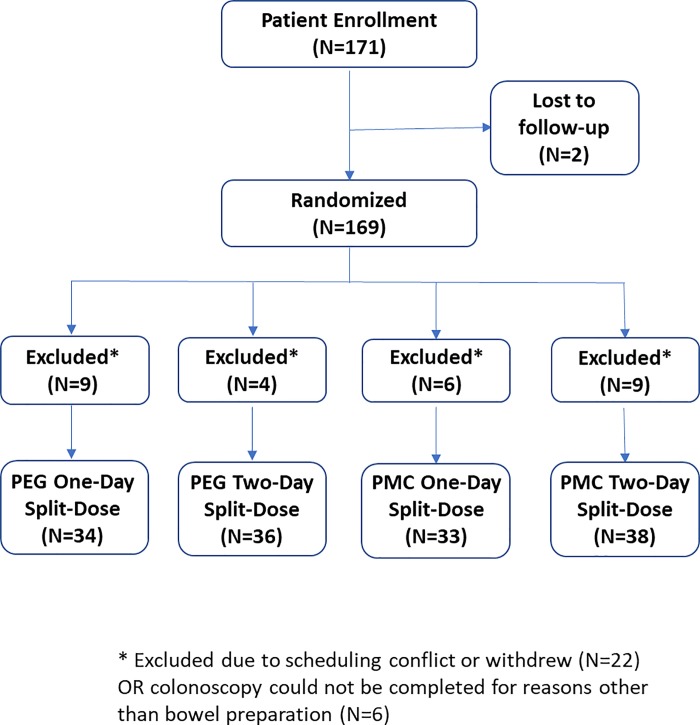
Study flow diagram.